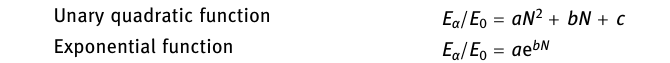
Table 7: Damage calculation model Unary quadratic function Exponential function